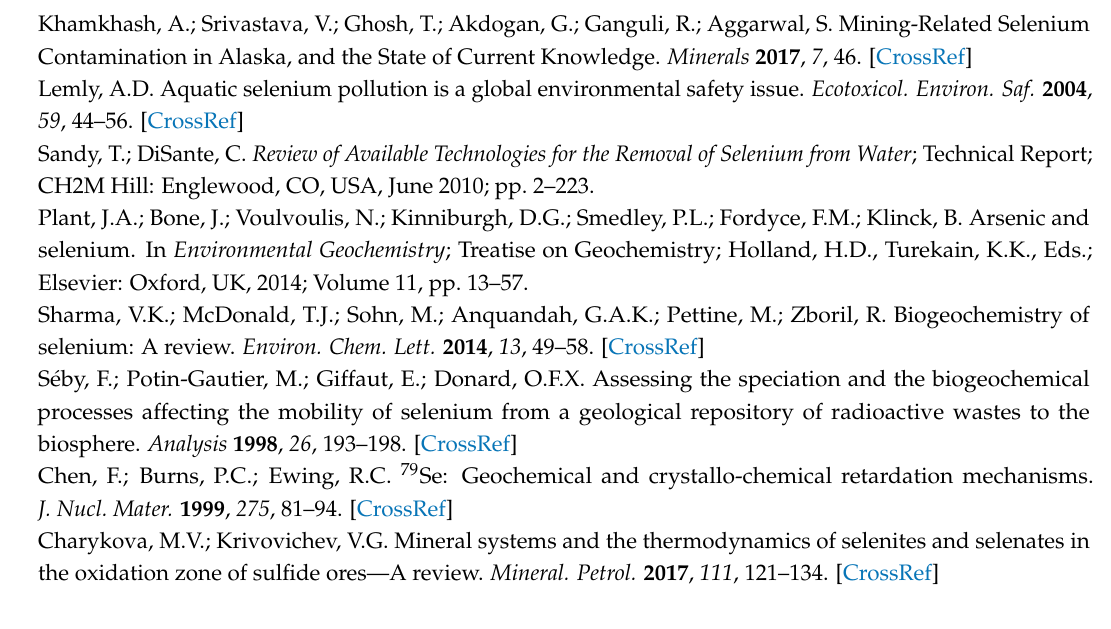
Table S1: Selenim minerals: Chemical formula, type locality (TL) and number of localities (NL). Acknowledgments: The three anonymous reviewers are thanked for their useful comments, which led to many important clarifications. This study was supported by St. Petersburg State University (Grants No. 3.38.286.2015; 3.42.732.2017) and the Russian Foundation for Basic Research (Grant No. 16-05-00293). The St. Petersburg State University Resource Centers “X-Ray Diffraction Methods” and “Geomodel” made their equipment available for this